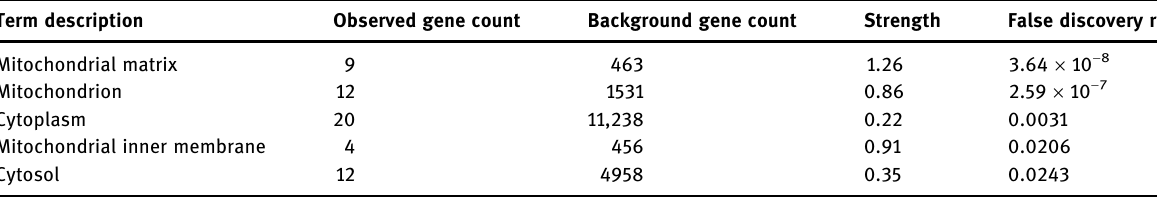
Table 2: CC enrichment for MTHFD2 and PPI network involved genes Term